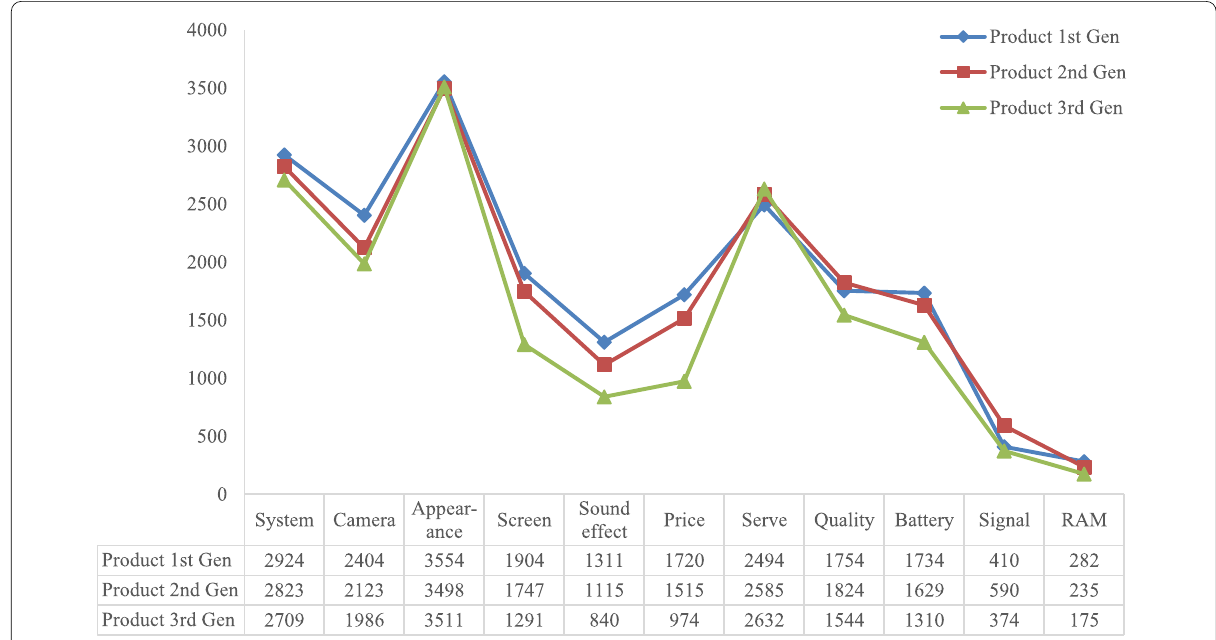
Figure 9 The attention scores for each product attribute of multi-generation